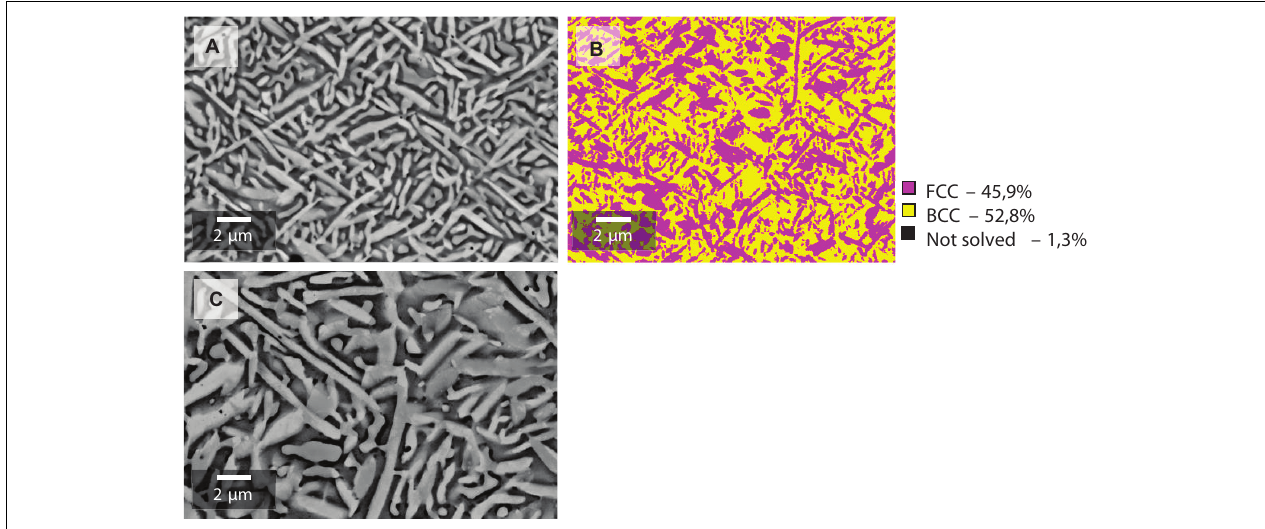
FIGURE 8 | SEM images of laser material deposition (LMD) fabricated samples with 450 ◦ C pre-heating temperature. A samples (A) and B samples (C) after heat treatment at 900 ◦ C for 6 h, and an EBSD phase analysis of A sample microstructure after heat treatment (B) . A duplex FCC/BCC microstructure is visible, and a 46%/53% (FCC/BCC) phase composition is